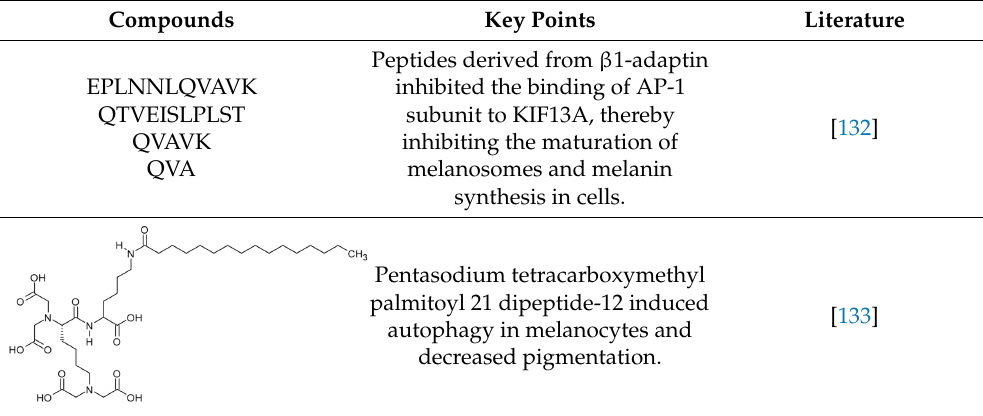
autophagy in melanocytes and decreased